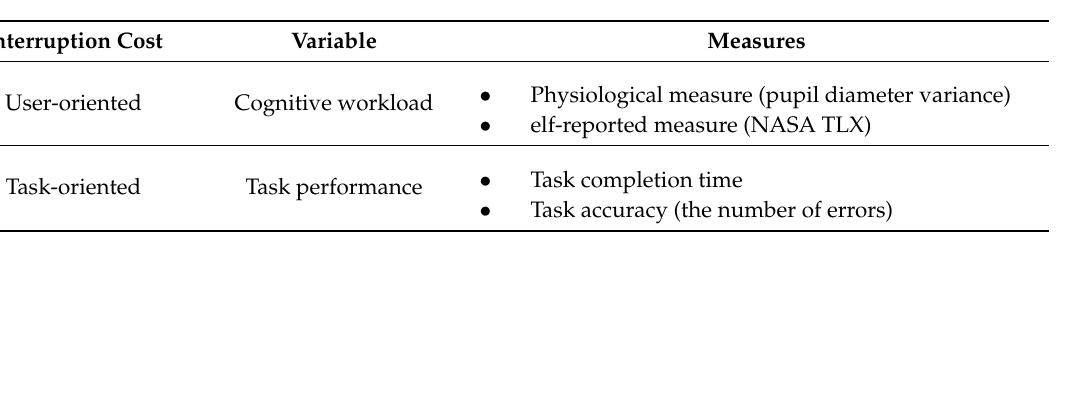
Table 1. Variables and measures of interruption cost. NASA TLX—National Aeronautics and Space Administration (NASA) task load